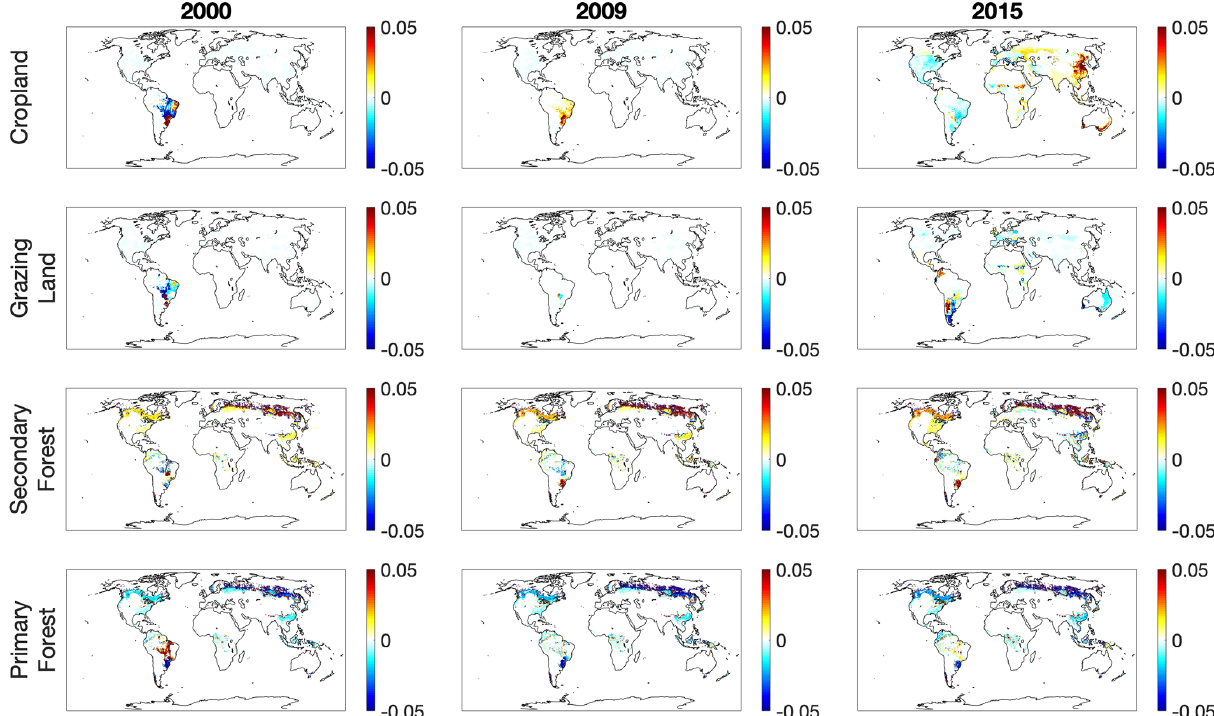
Figure 5. Mapped differences (LUH2-GCB2019 – LUH2 v2h) in fractions of each 0.25 ◦ grid cell for cropland, grazing land, secondary forest, and primary forest in 2000, 2009, and